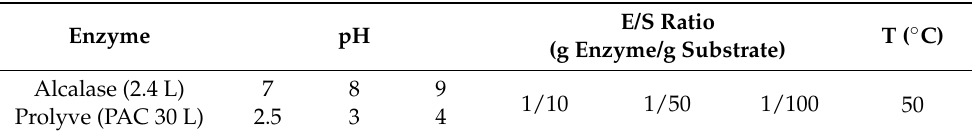
E/S Ratio T ( ◦ C) (g Enzyme/g Substrate)